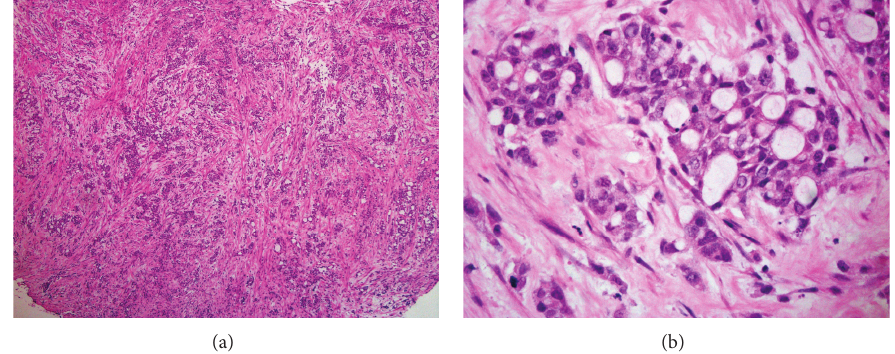
Figure 2: (a) Hematoxylin and eosin (H&E) staining showing reticular, solid, microcystic, adenoid cystic patterns, and desmoplastic stroma. (b) H&E staining showing pleomorphic cells with large vesicular nuclei with variable